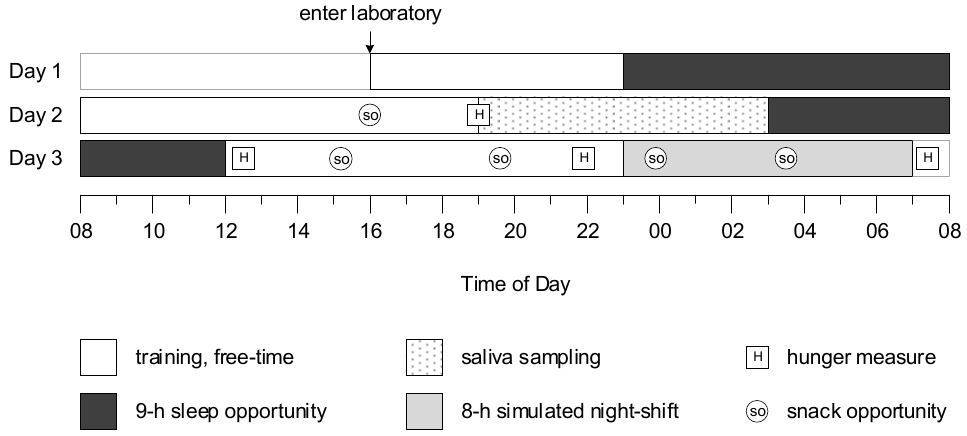
Figure 1. Protocol diagram, in which y -axis represents day of the protocol, and x -axis represents time of day. Baseline measures were collected on Day 2.